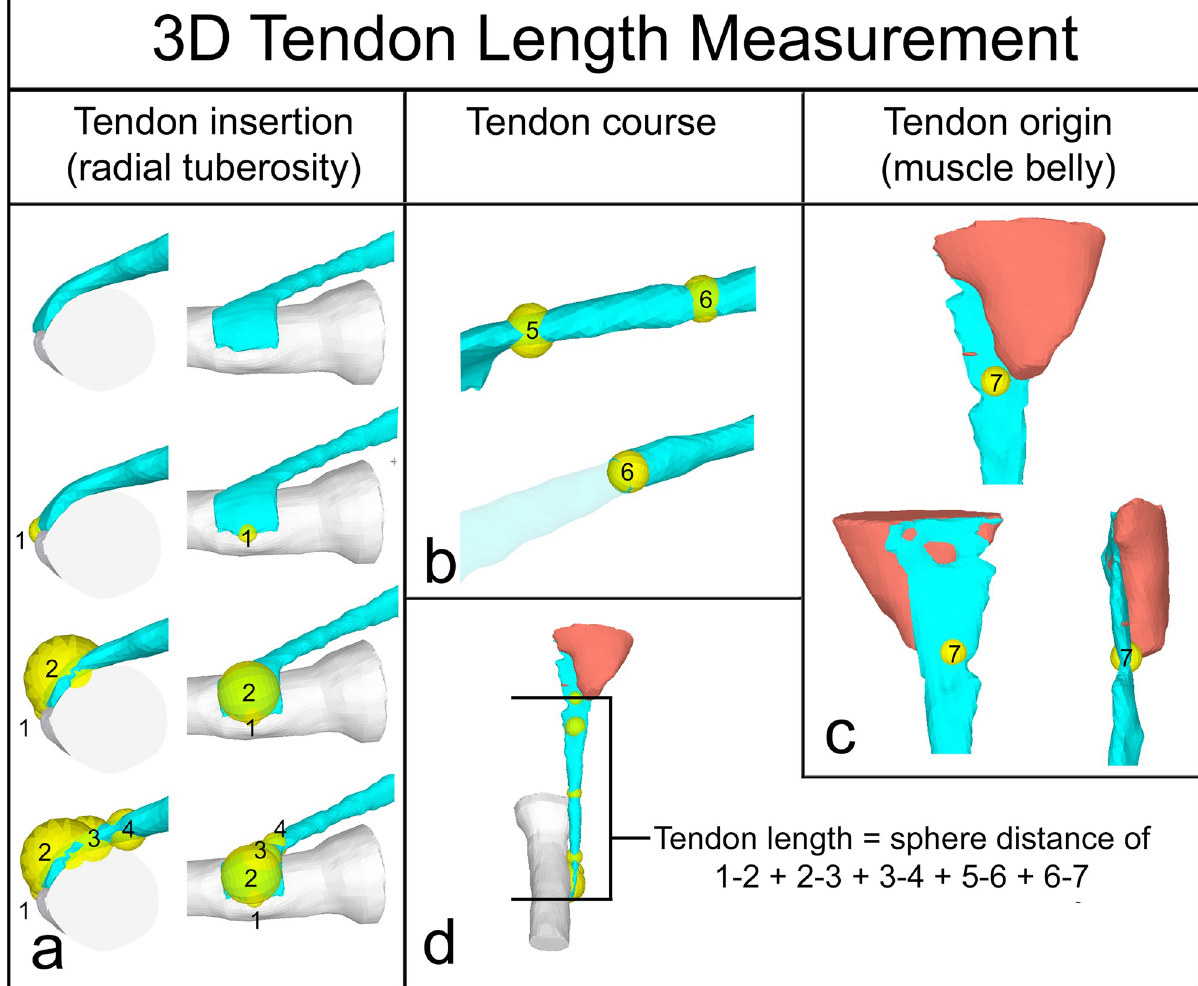
Fig 3. 3D tendon length measurement. 3D tendon length measuring from the distal myotendinous junction to the insertion on the bicipital tuberosity: a) Tendon insertion (radial tuberosity): The first sphere was placed on the tendon insertion, centered on the radial tuberosity. b) Tendon course: 4–8 further spheres were placed along the entire tendon, wherever the tendon changed the direction. c) Tendon origin (muscle belly): The last sphere was placed at the distal myotendinous junction. d) Tendon length measuring: The tendon length was measured as the distance of the center of the sphere 1–2 + 2–3 + 3–4 + 5–6 +